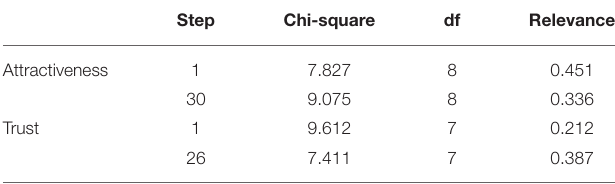
TABLE 4 | Goodness of fit test results from Hosmer and